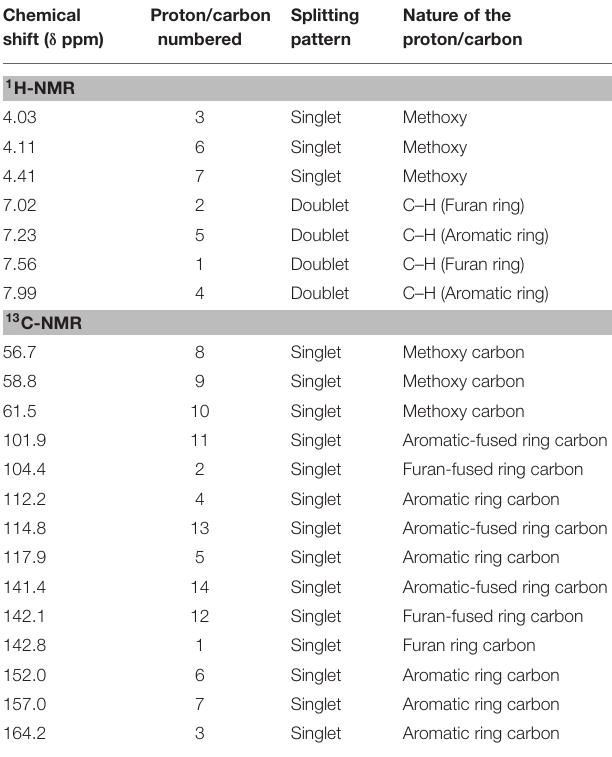
TABLE 2 | Elemental analysis of arborine and skimmianine compounds. Compound name Elements Theoretical value (%) Observed value (%)